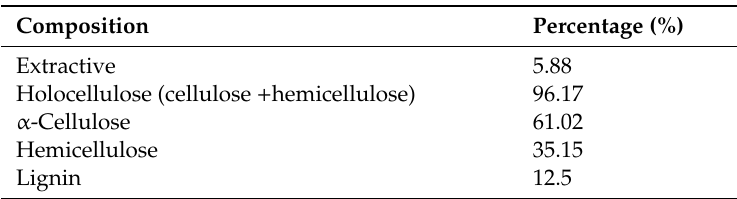
Table 1. Composition of kenaf fibers.